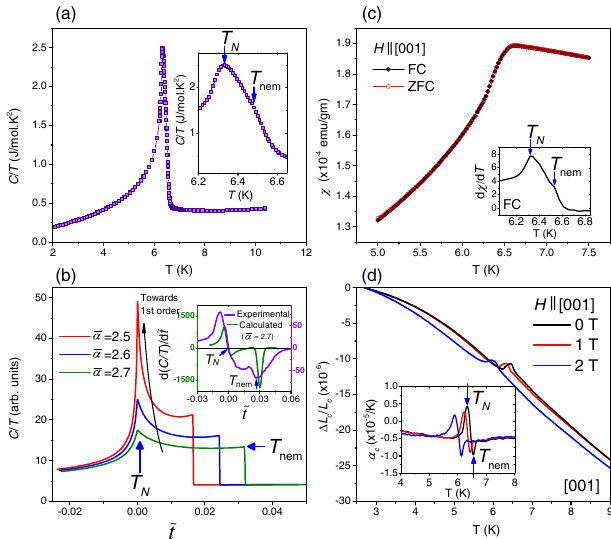
FIG. 1. (a) Specific heat divided by temperature of CeAuSb 2 at ambient pressure. The inset is a magnified view near the peak position. Arrows indicate the transition temperatures T and nem T . (b) Calculated C=T versus reduced temperature for fixed N anisotropy ζ and various inverse nematic coupling strength ¯ α . The inset gives the derivative of C=T of the experimental data (purple) and of the calculations with ¯ α ¼ 2 . 7 (green). The theoretical curve was shifted and averaged over disorder for better com- parison with the experimental data; details are given in the Supplemental Material [45]. (c) Temperature-dependent mag- netic susceptibility in an applied field of 1 kOe along the c axis. ZFC (zero-field cooled; open circles) and FC (field-cooled; solid circles) curves show two transitions without hysteresis. The inset plots the derivative d χ = d T . (d) Temperature dependence of the thermal expansion Δ L=L of CeAuSb 2 along ½ 001 (cid:2) at zero field, 1 T, and 2 T applied along the c axis. The inset gives the thermal expansion =T (i.e., increase or decrease) below T , whereas a N nem number of intensities also appear unaffected. Within the limited resolution of this experiment ( Δ d=d > 10 − 4 ), we observe no evidence for a lattice distortion. As illustrated by the insets in Fig. 2, however, four peaks appear at low temperatures, which are not indexed in the parent phase and thus confirm that the true symmetry of the low-temperature phase of CeAuSb 2 is lower than that of the P 4 =nmm space group. Because of the powder average and the limited